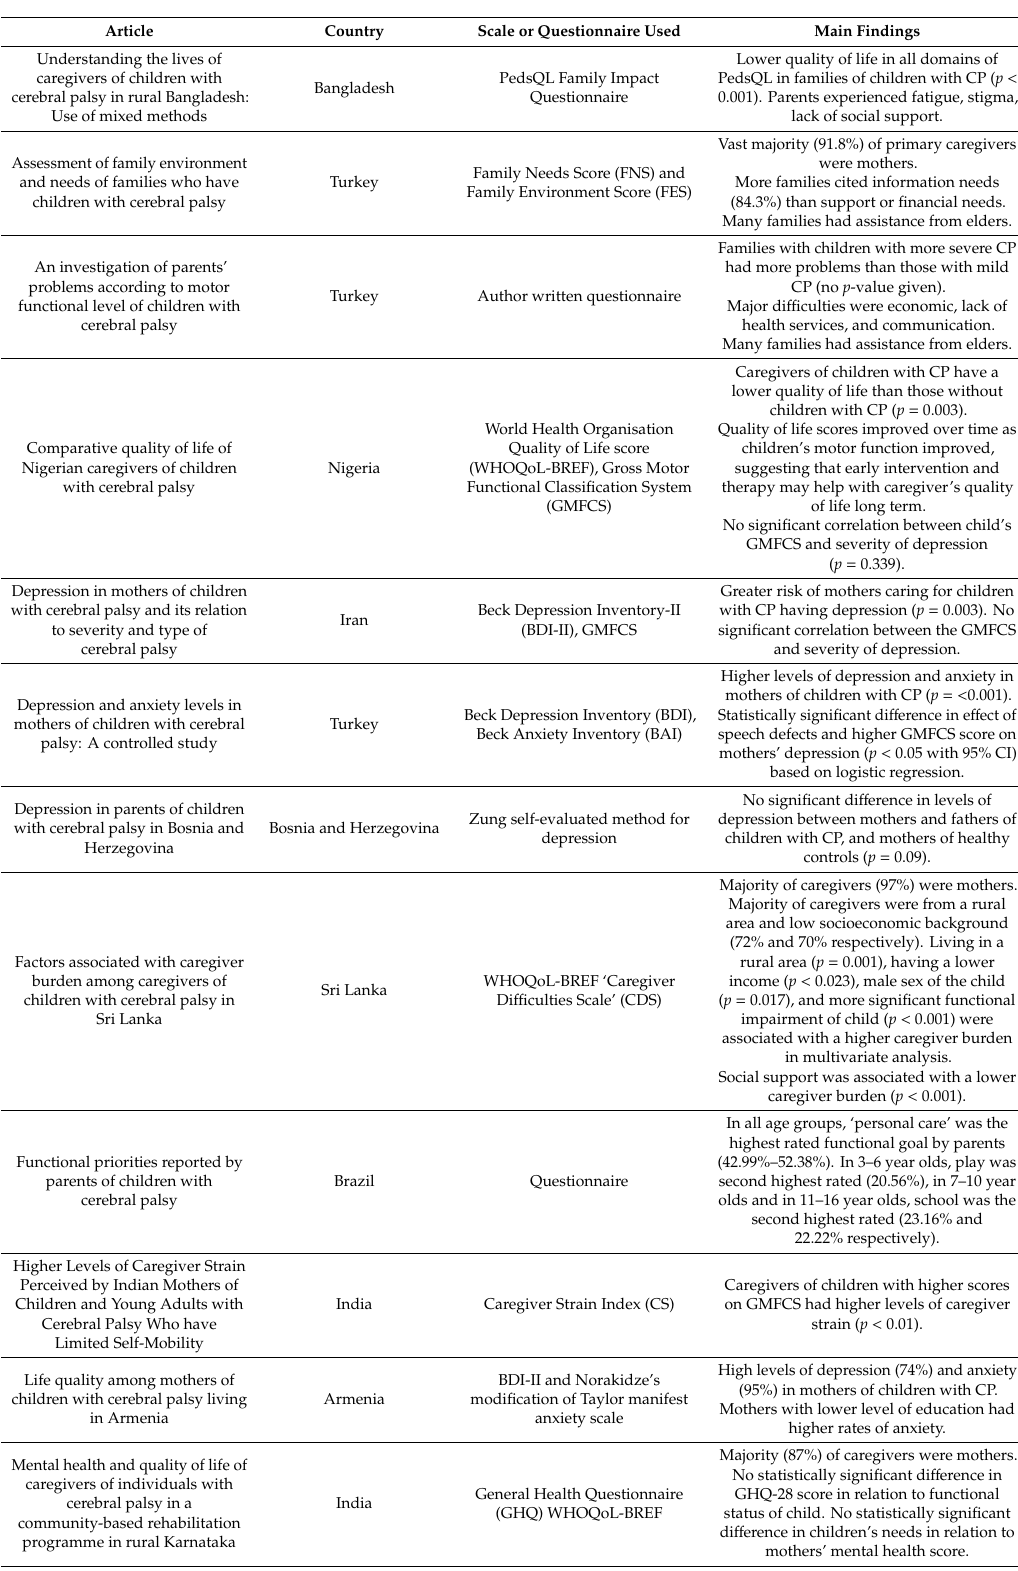
Table 2. Overview of findings of CP studies